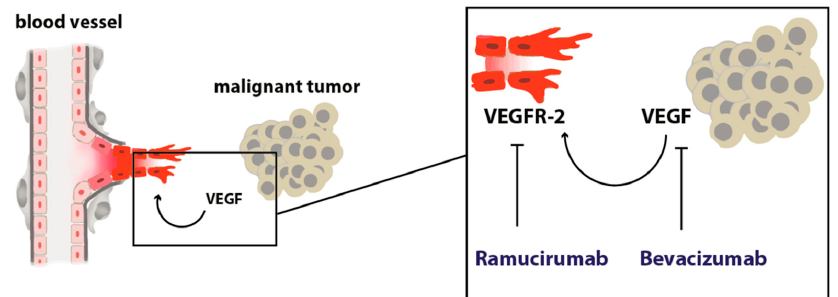
Figure 1. Scheme depicting the angiogenic switch. A malignant tumor secretes pro-angiogenic growth factors that stimulate angiogenesis by acting on endothelial cells with pro-migratory, proliferative, and anti-apoptotic, pro-survival signals.